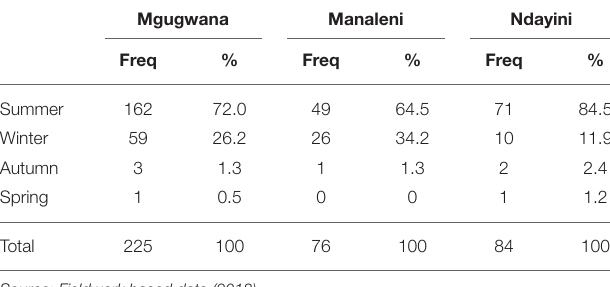
TABLE 1 | Seasons that climate change becomes a severe problem.